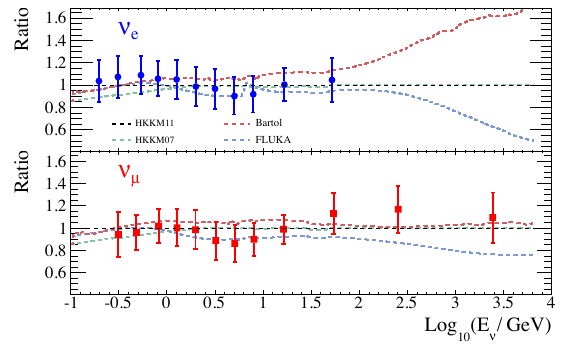
Figure 3. The measured energy spectra of the atmospheric ν e and ν µ fluxes by Super-Kamiokande, shown with measurements by other experiments.